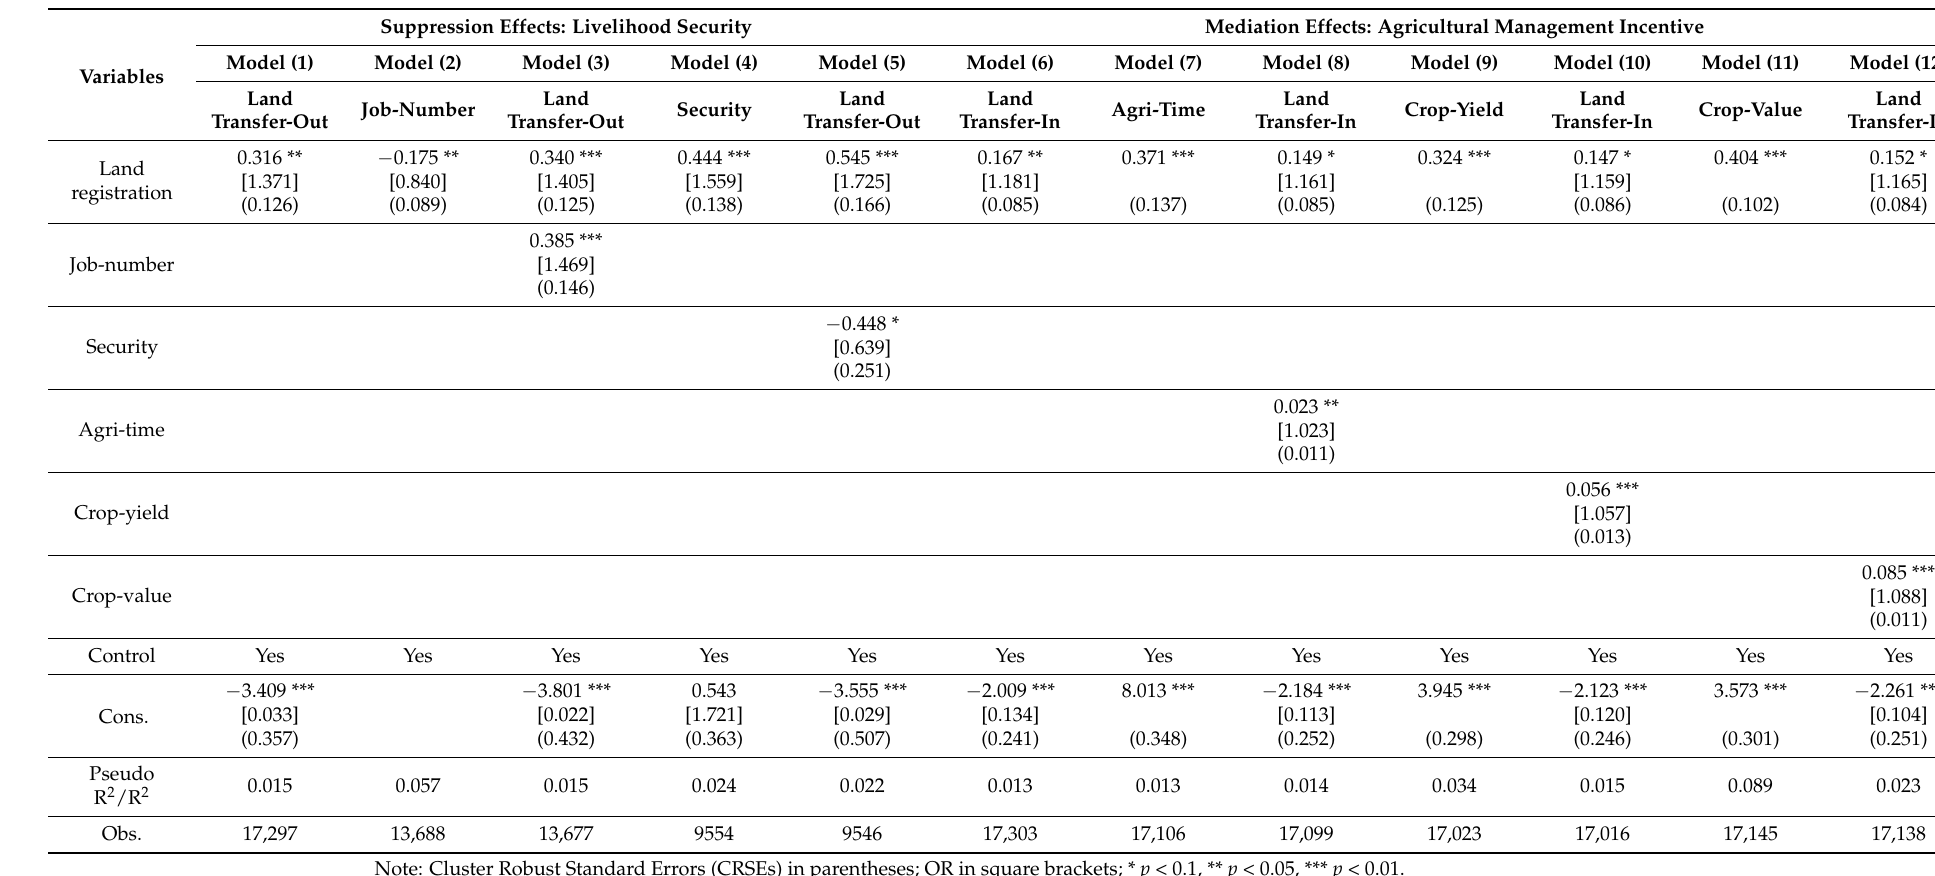
Table 5. Estimation results of mediating effects of livelihood security and agricultural management